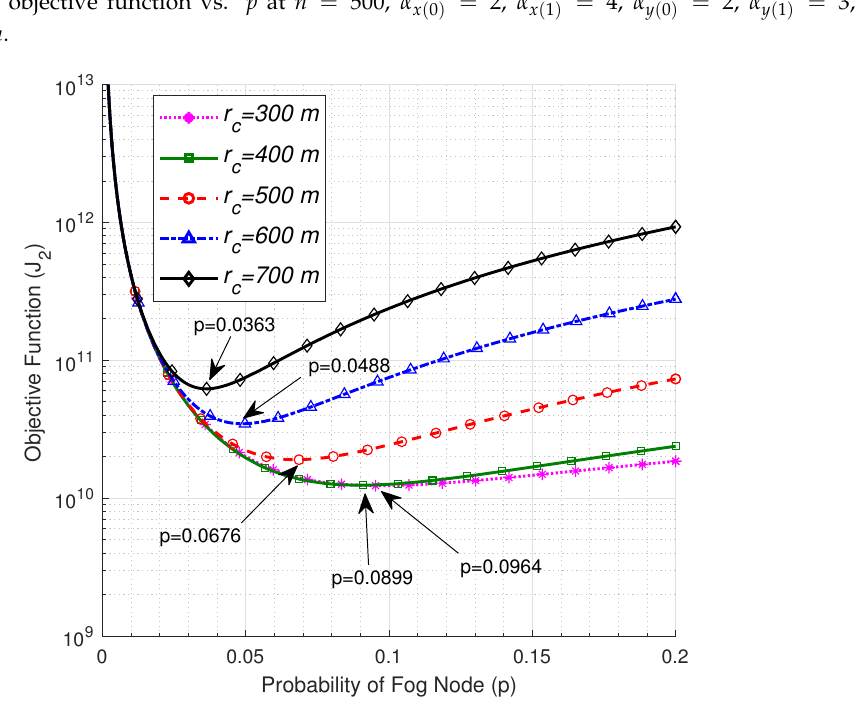
Figure 7. The objective function vs. p at n = 500, α x ( 0 ) = 2, α x ( 1 ) = 4, α y ( 0 ) = 2, α y ( 1 ) = 3, and r f = 100 m